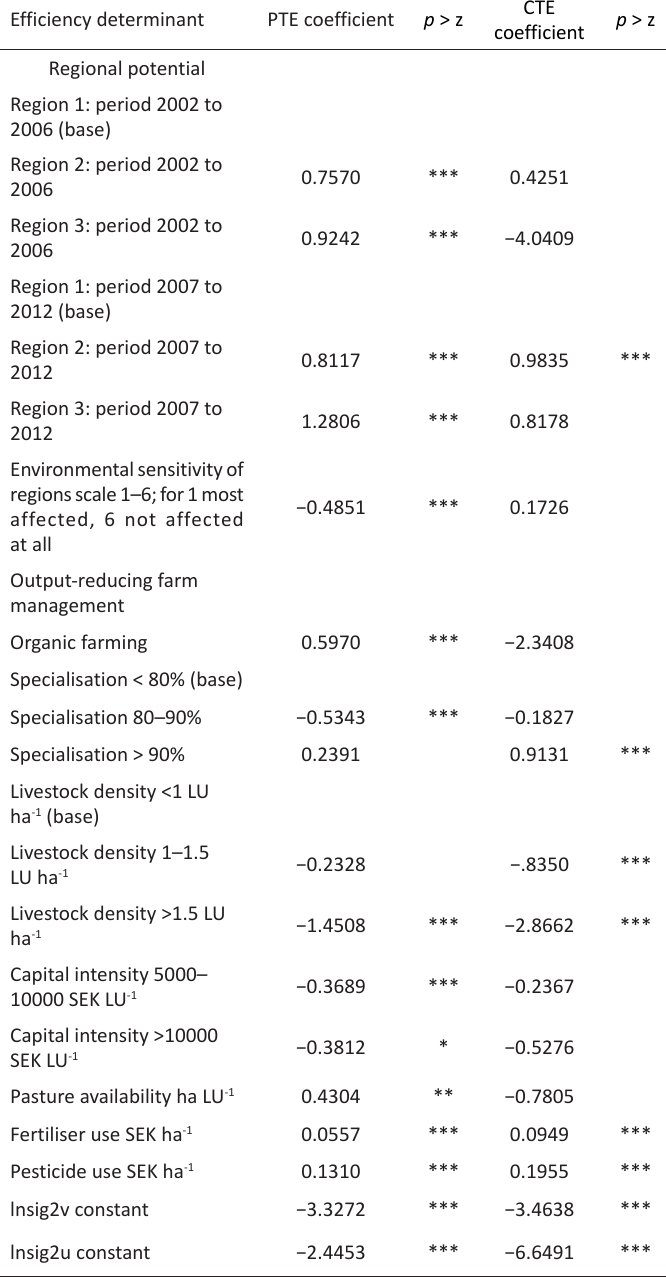
Table 3. Summary of the results of the inefficiency effect model for pure and compensated technical efficiency (TE) Efficiency